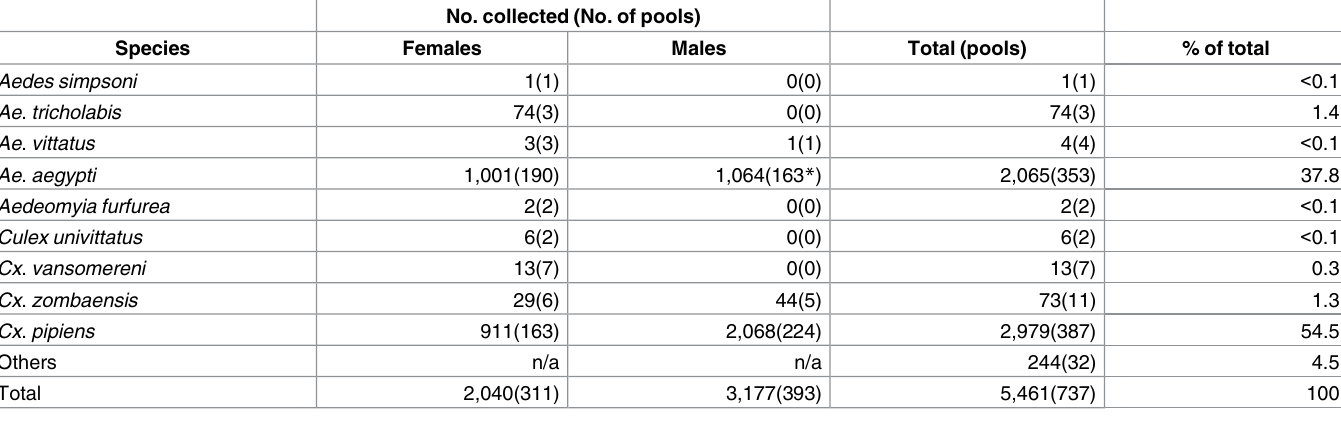
Table 6. Mosquito species collected as adults by various methods